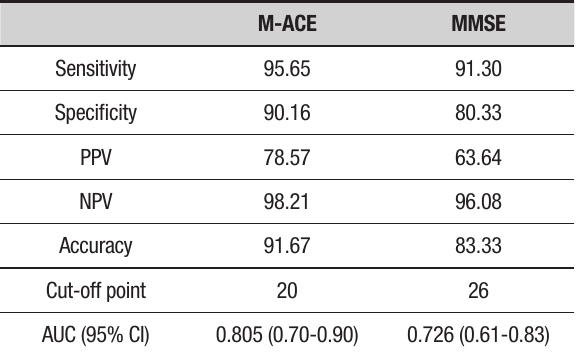
Table 2. Sensitivity, specificity, PPV, NPV of the M-ACE versus MMSE (AD versus MCI and Control).